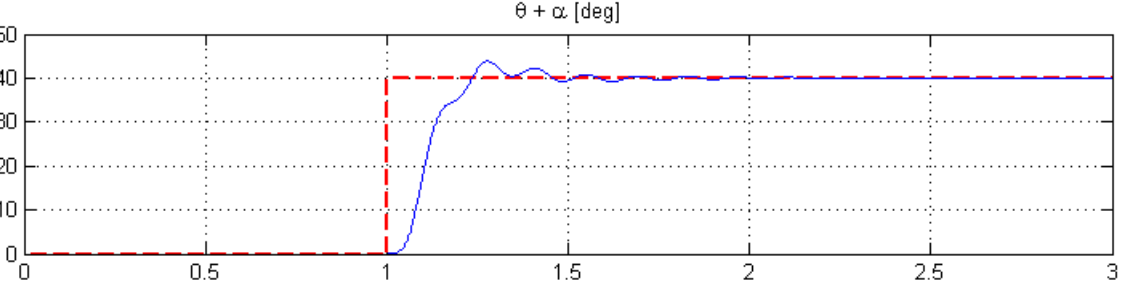
Figure 3. Time response of the closed-loop system with DLQR controller. 𝑹 = 𝟏, 𝑸 = 𝒅𝒊𝒂𝒈([𝟏,𝟏, 𝟎, 𝟎]) .